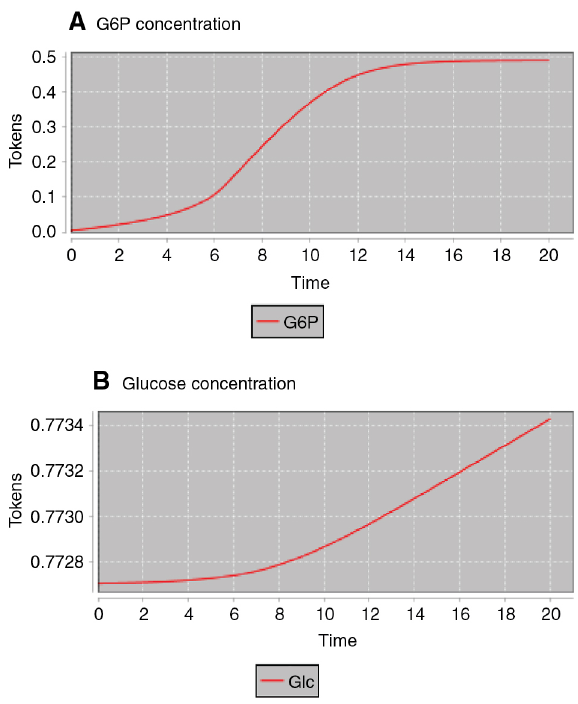
Figure 4: Simulation results of G6P and